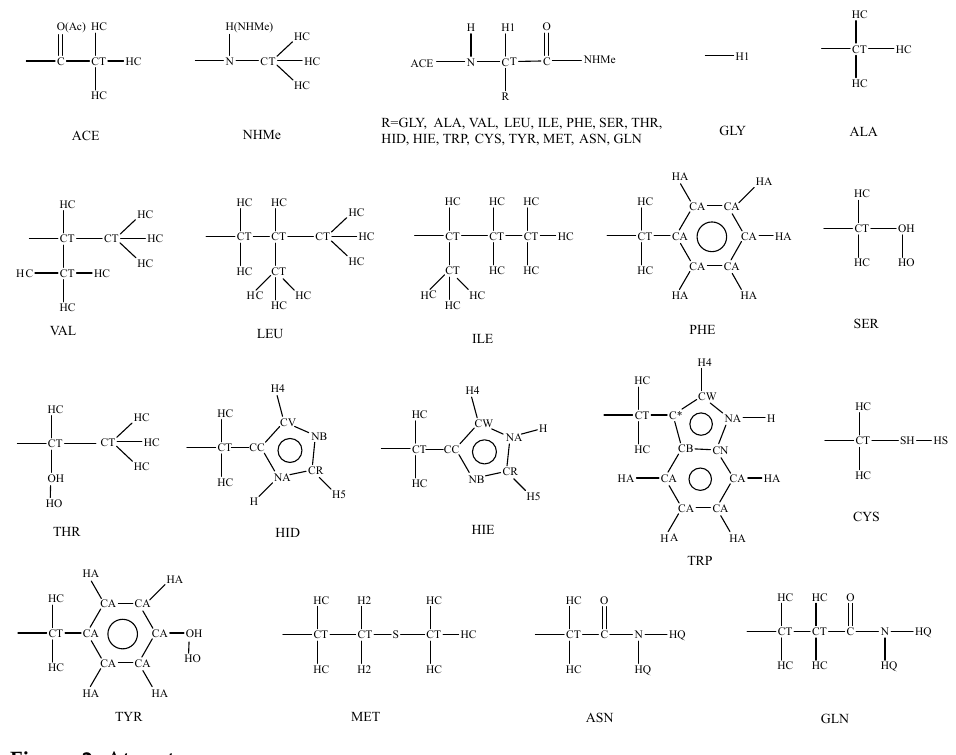
Figure 2. Atom types.